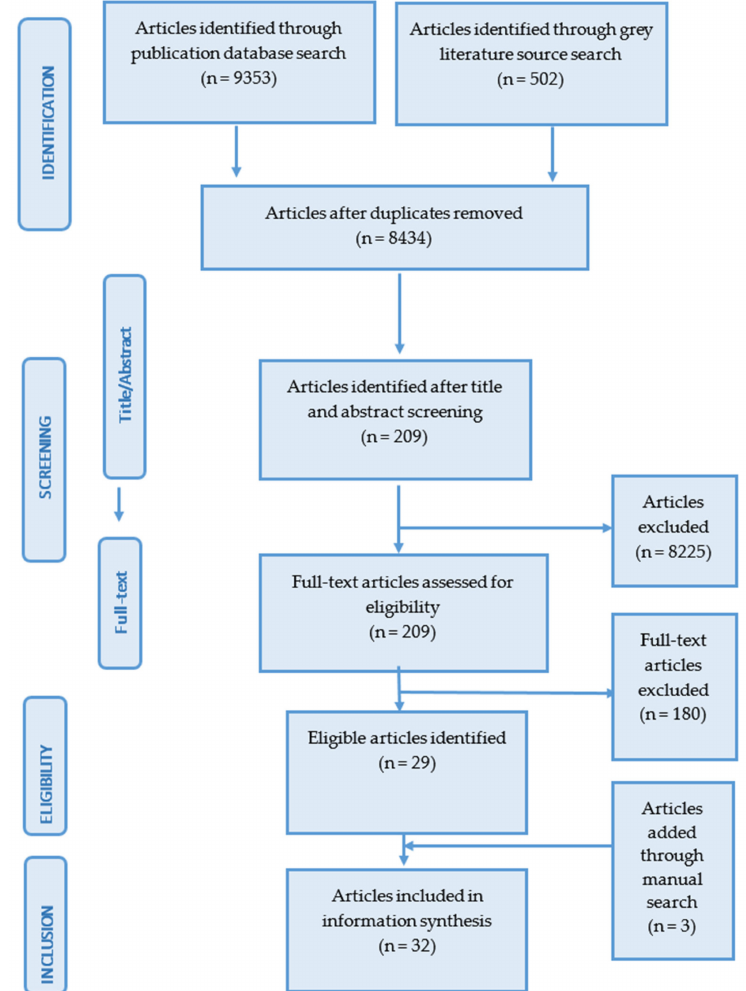
Figure 1. Search and screening steps for this